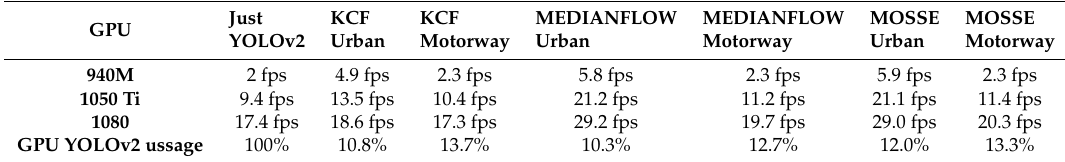
Table 4. Comparison between traffic environments: YOLOv2 and YOLOv2 + Tracking algorithms.